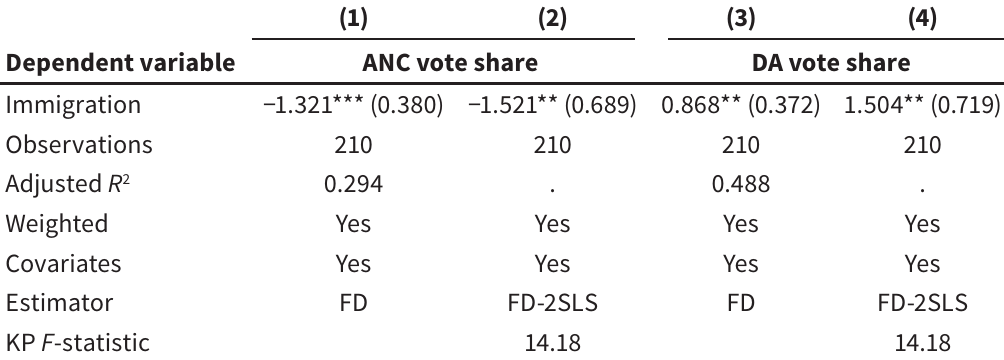
Notes : Robust standard errors clustered at the district level in parentheses. Census data for 2001 and 2011 (IPUMS International). National election results from 2004 and 2014 (Electoral Commission). First differenced regressions. Covariates defined at the municipality level and as a share of the relevant native population include urban population, female popula- tion, unemployment rate, internal migration, ethnic diversity measured as the Herfindahl index based on languages spoken, access to electricity, and adult illiteracy (no schooling). Immigration is instrumented with a shift-share Bartik instrument using 1991 census